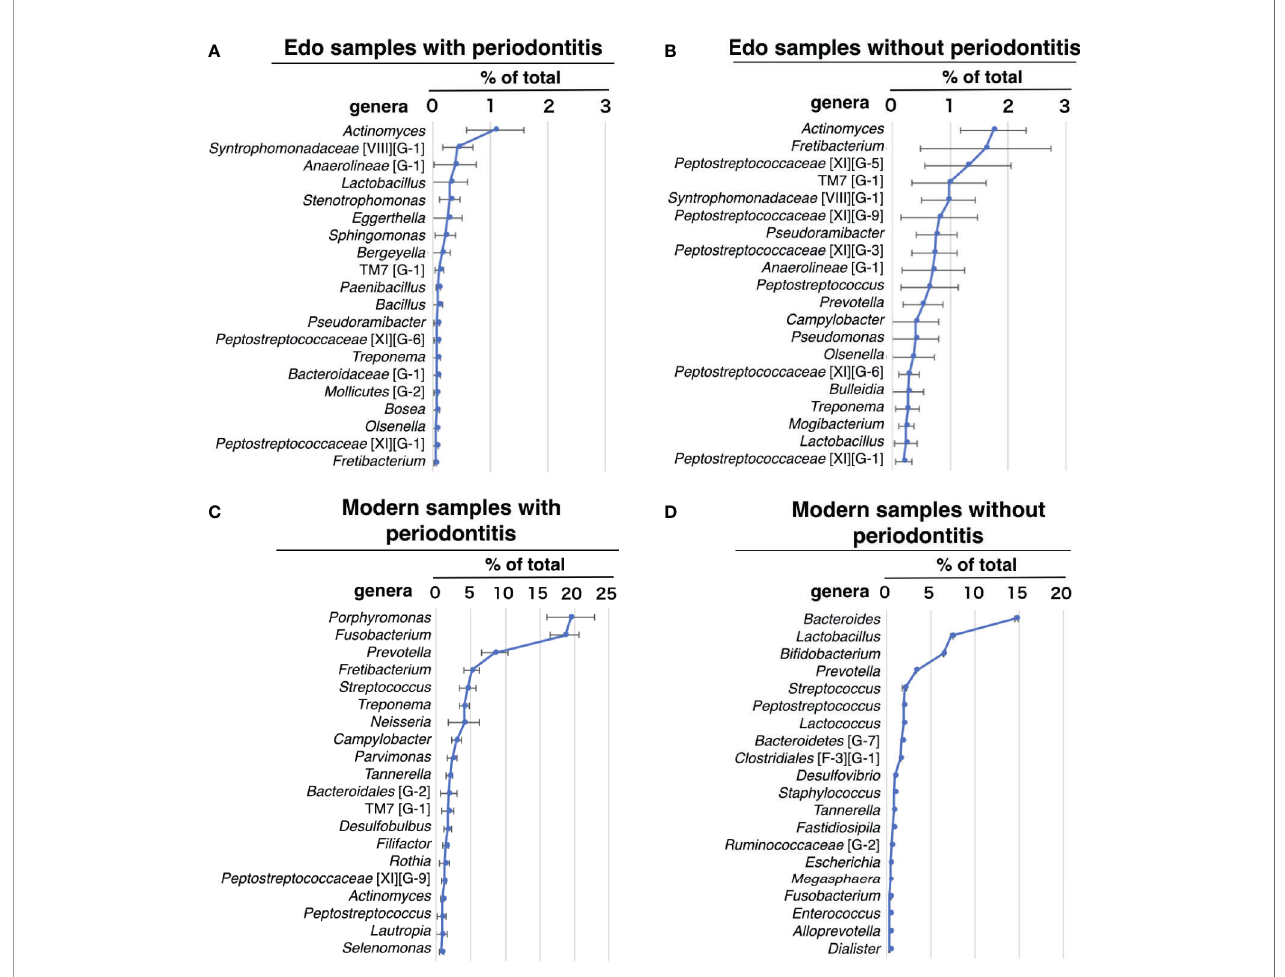
FIGURE 5 | Percentage compositions of genus. (A) Edo sample with periodontitis, (B) Edo sample without periodontitis, (C) modern samples with periodontitis, and (D) modern sample without periodontitis. The bars show mean ± SE relative abundances.